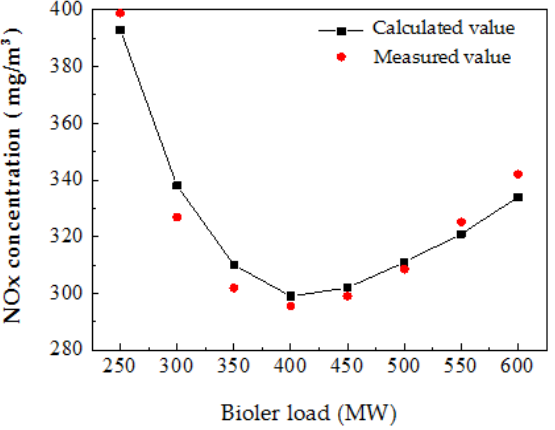
outlet do not exceed 3.3% under different loads, which further proves the accuracy and